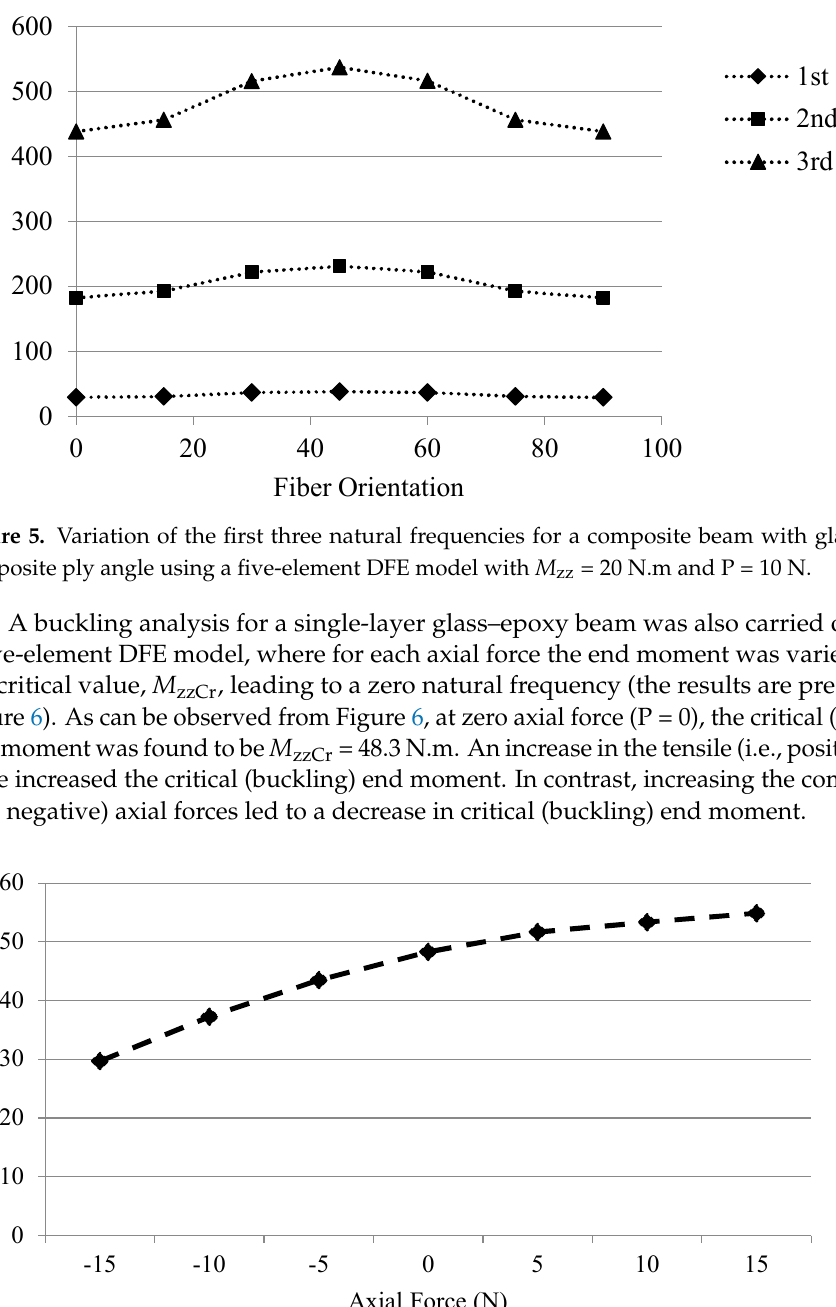
11 Figure 4. Variation of the fundamental natural frequency vs. axial compressive force for M zz = 20 N.m, obtained from the five-element FEM and DFE models. The effect of fiber angle on the vibrational behavior of the composite glass–epoxy beam was also investigated using a five-element DFE model, and the results are repre-